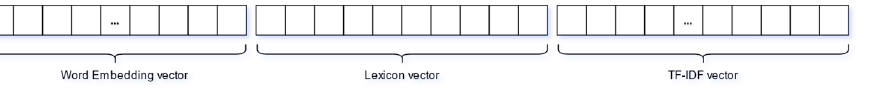
Figure 9. WE_Lexicón_TF-IDF feature vector.